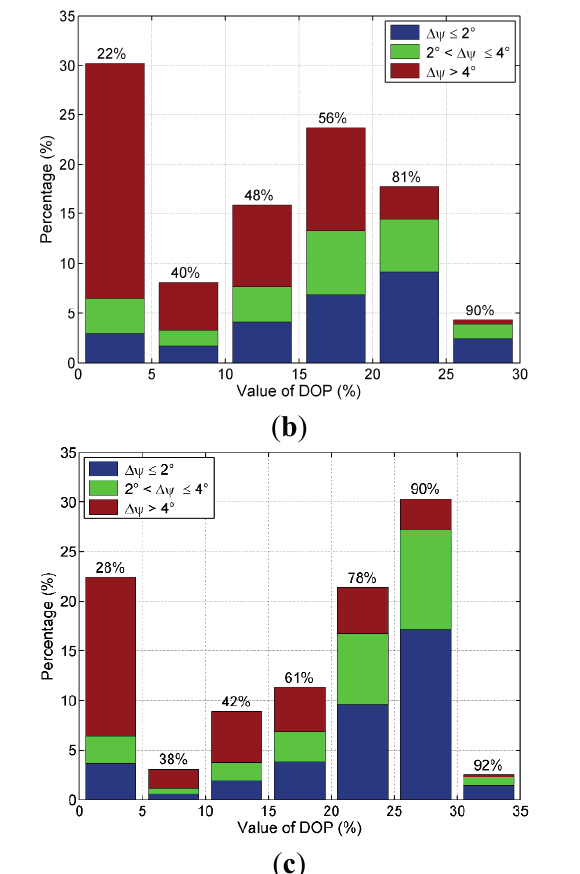
Figure 8. The distribution of the AOP deviations in different DOP intervals. ( a ) Clear sky; ( b ) Cloudy sky I; ( c ) Cloudy sky II.